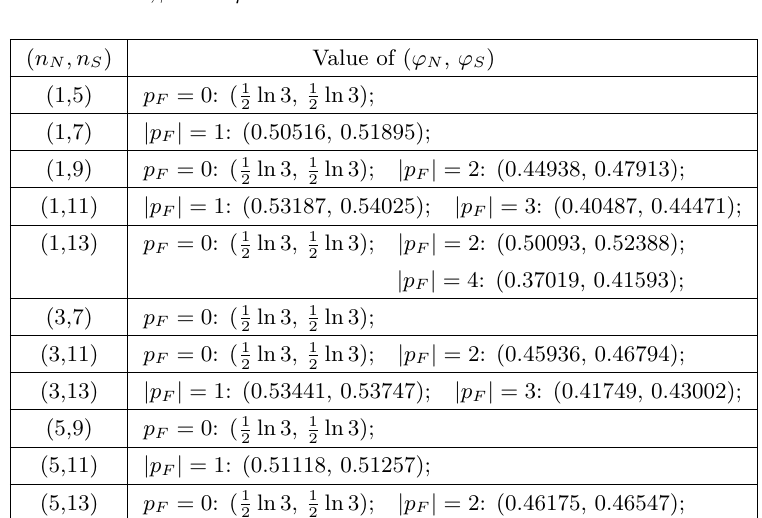
Figure 1 . An AdS 3 × Σ solution in the anti-twist class with n N = 1 , n S = 7 and p F = 1 . In the left panel we have plotted the metric functions e V and h while in the right panel we have plotted the three scalar functions α, β and ϕ .